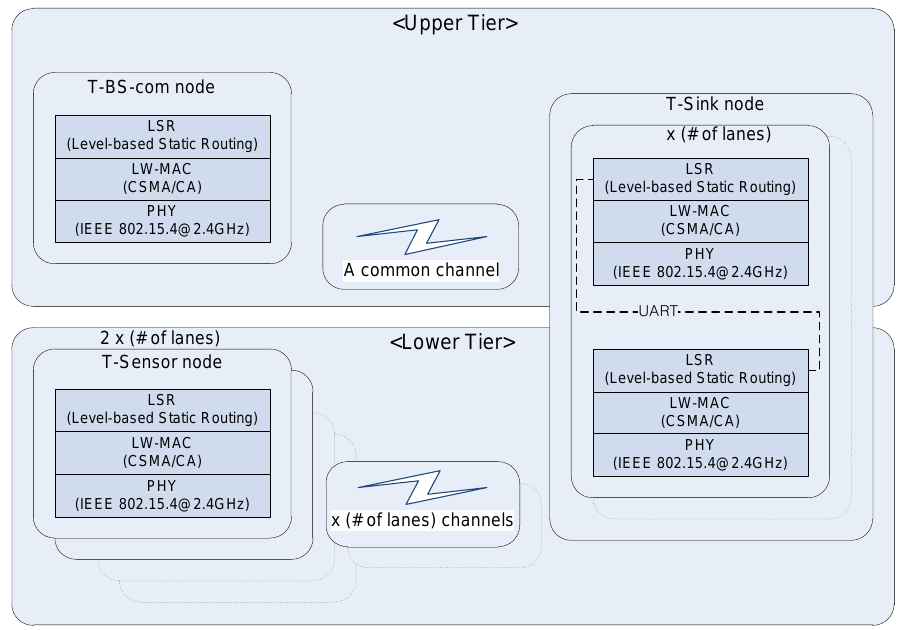
Figure 2. Network architecture of TSN.